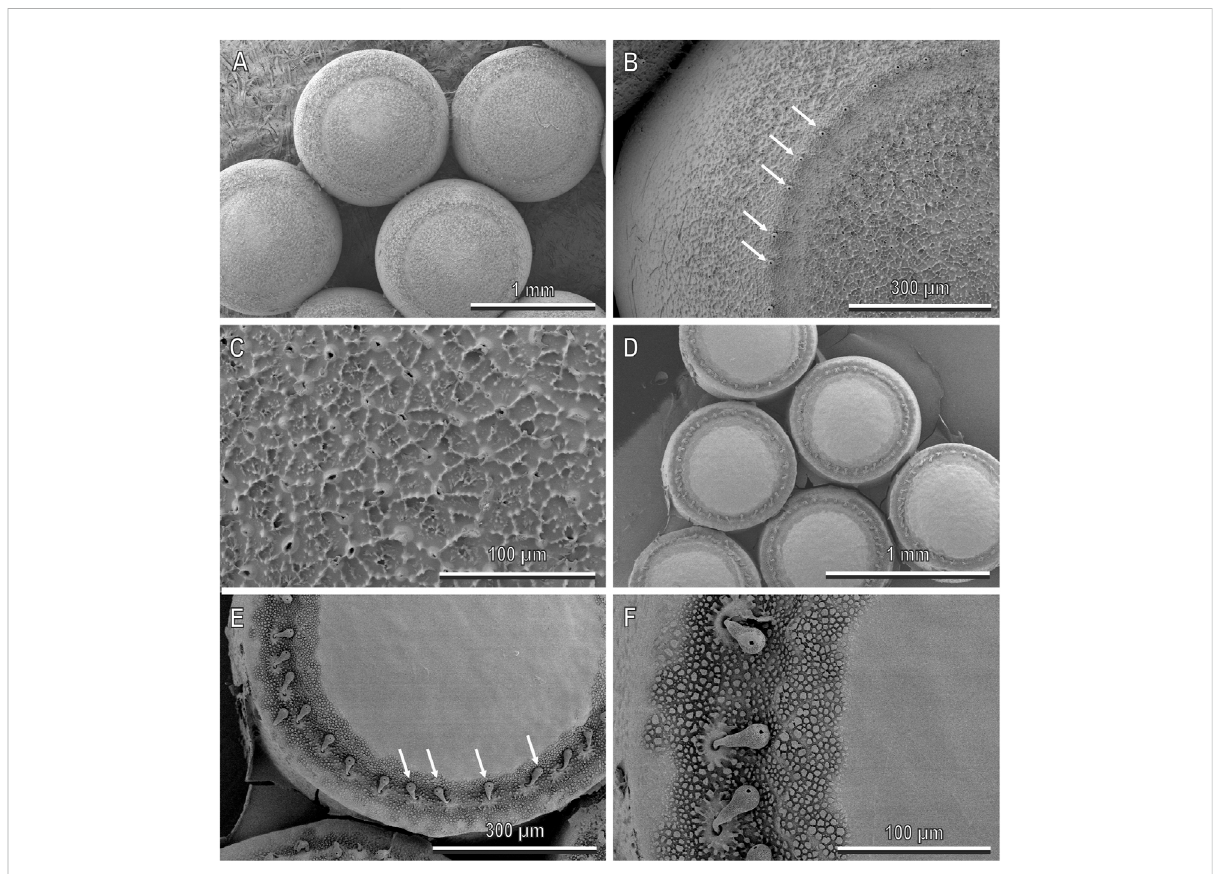
FIGURE 7 Eggs of H. halys (A – C) and N. viridula (D – F) in cryo-SEM, dorsal view. (A,D) , Egg clutches. Each egg of H. halys has a subspherical shape (A) , roughsurface (C) andcrownofaeromicropilarprocessesalongtheapicaleggsurface(arrows) (B) .Eacheggof N.viridula hasabarrelshapewitha fl at top (D) , smooth surface (E,F) and crown of aeromicropilar processes (arrows) located along the apical surface (E)